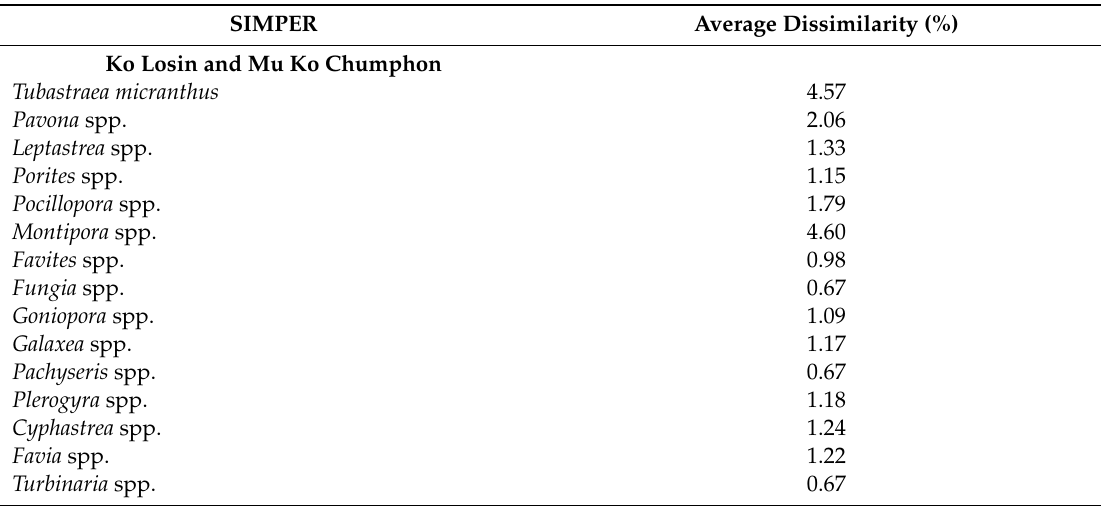
Table 3. SIMPER analysis of the composition of juvenile corals at the study sites.